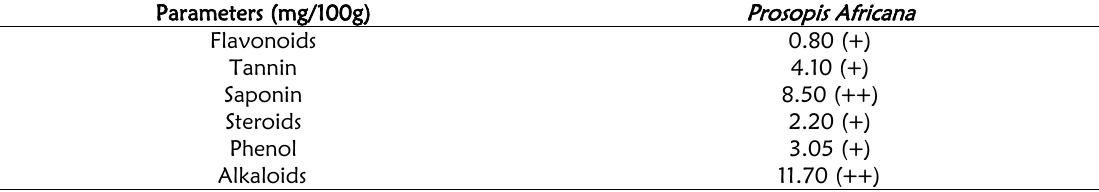
Table 3: Qualitative and quantitative analyses of Prosopis Africana seed extract